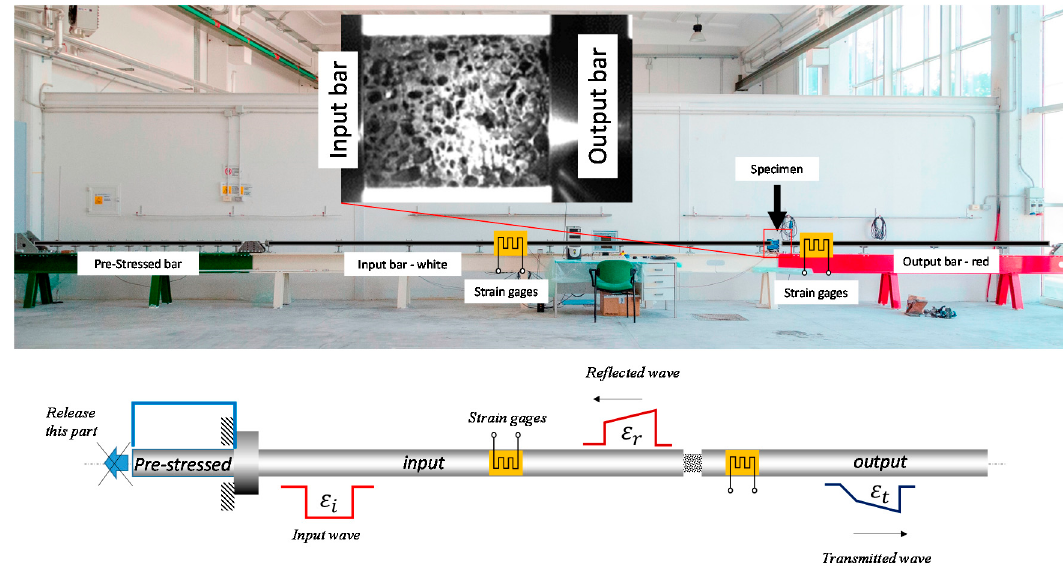
Figure 2. Hopkinson bar facility image and scheme.